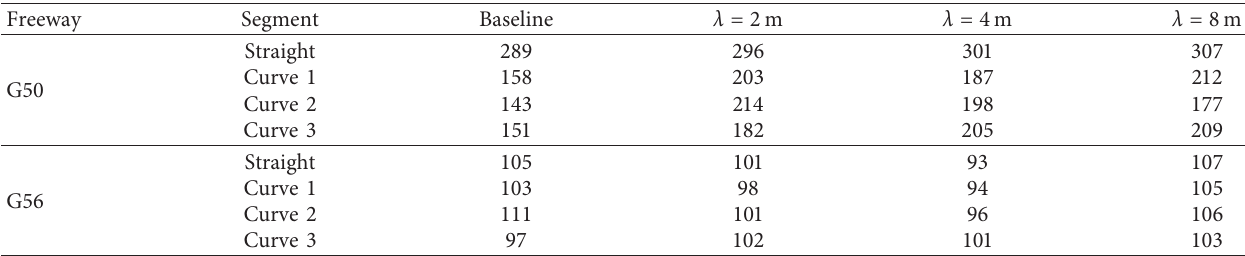
Table 2: The effective sample